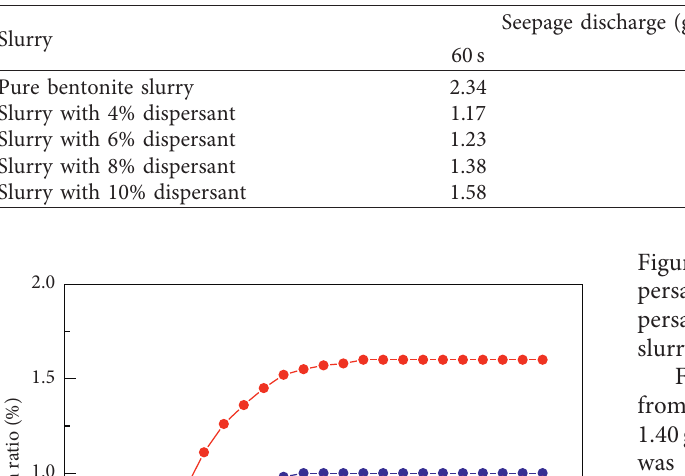
Table 1: Slurry properties.